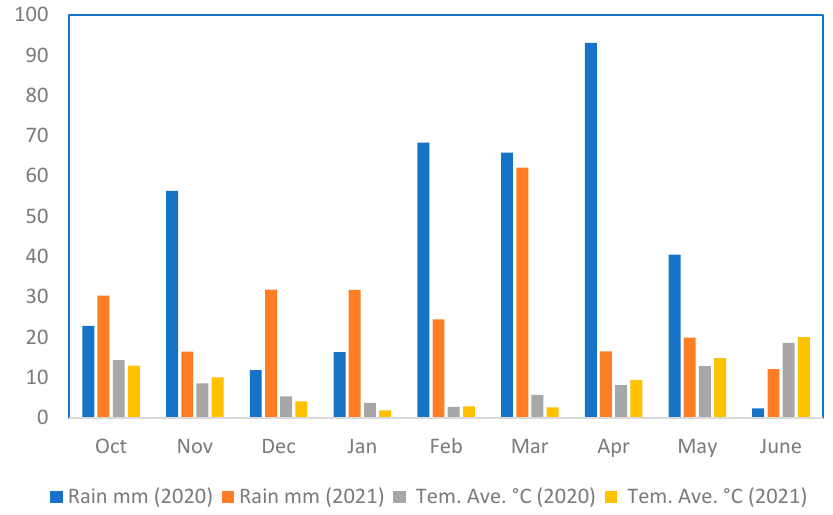
Figure 1. Rainfall and temperature in the experimental